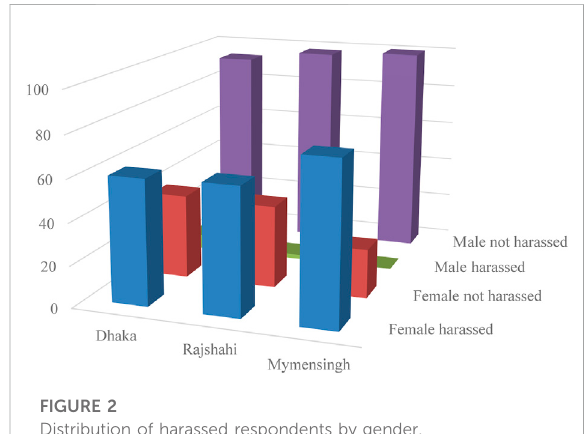
FIGURE 2 Distribution of harassed respondents by